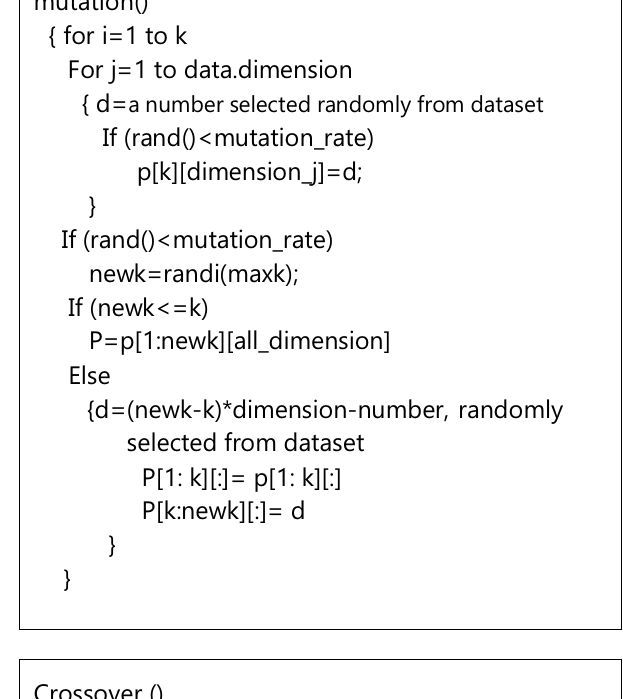
Fig. 2. The main steps of the proposed method.